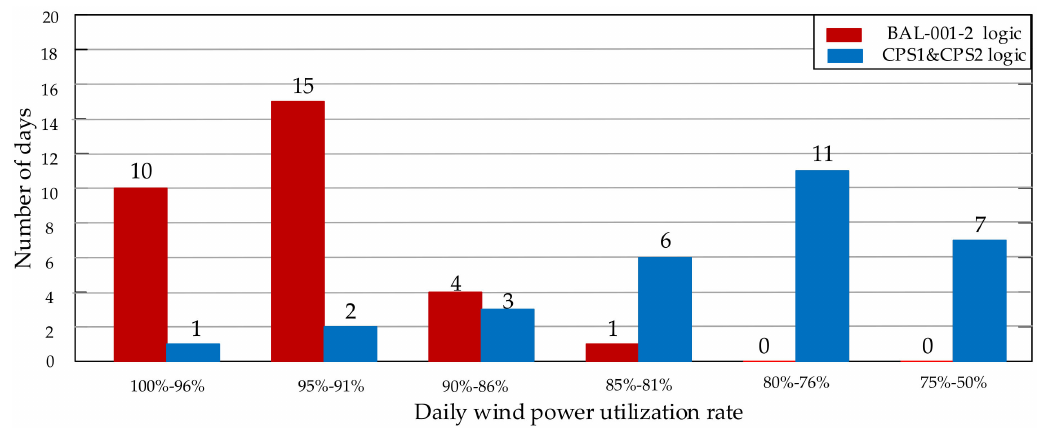
Figure 5. Distribution of days in different ranges of daily wind power utilization rate with the two